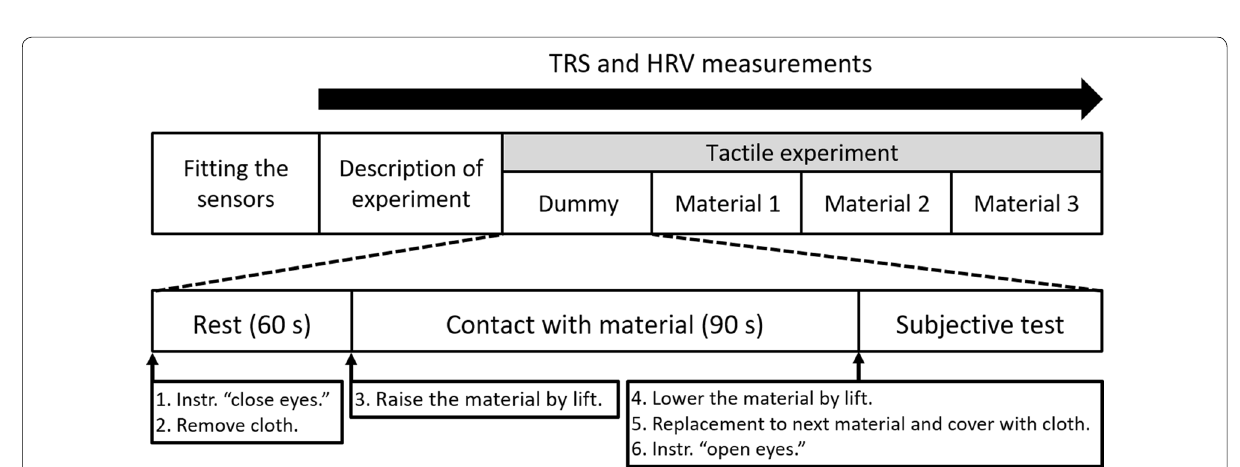
Fig. 3 Procedure for the entire experiment. The order of contact with the material was counterbalanced. TRS near-infrared time-resolved spectroscopy, HRV heart rate variability, Instr instruction to the